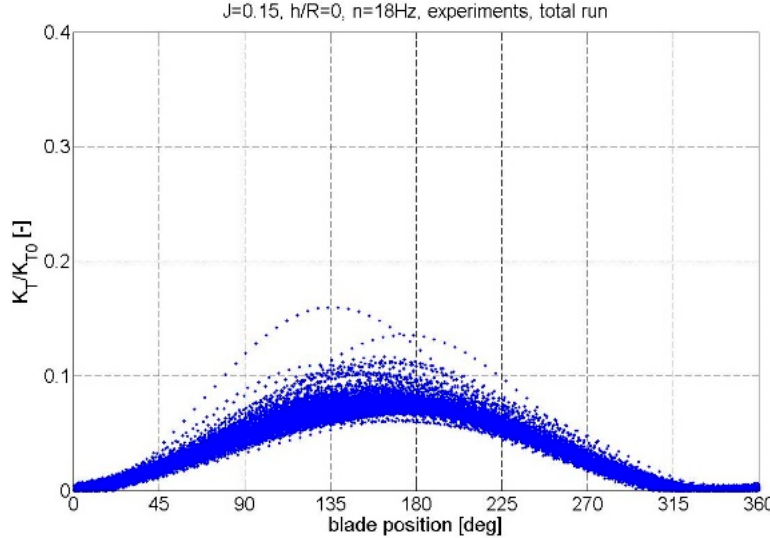
Figure 15. Thrust loss factor as a function of blade position based on experimental results (Koz10).